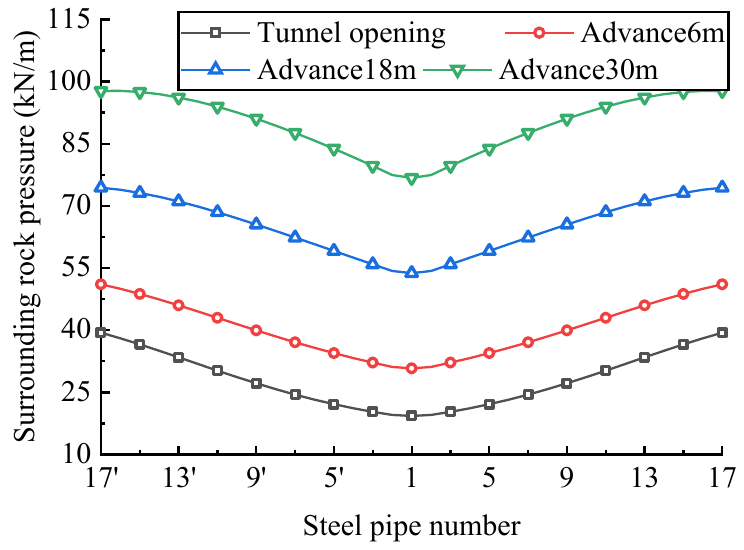
Figure 4. Surrounding rock pressure distribution of steel pipes on different sections.